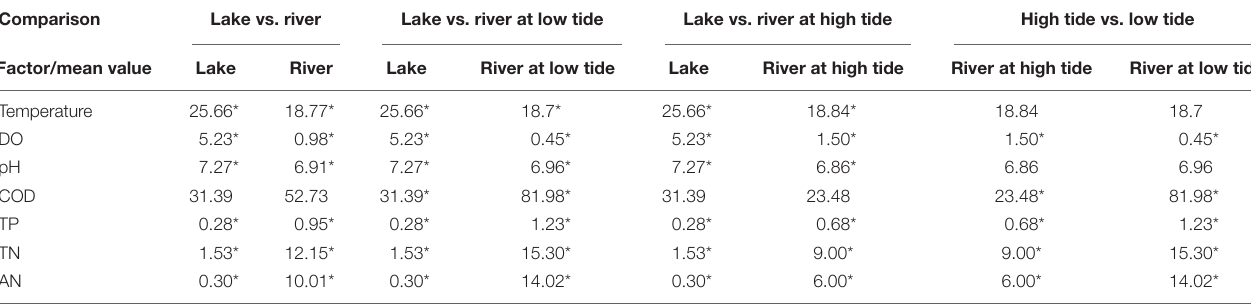
TABLE 1 | The comparisons for difference of environmental factors among lake, river, river at high tide, and river at low tide. Comparison